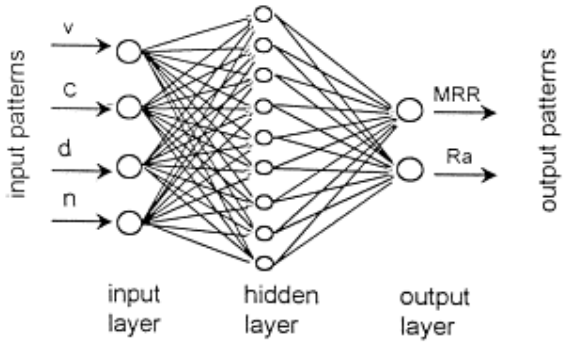
Figure 44. The structure of ANN